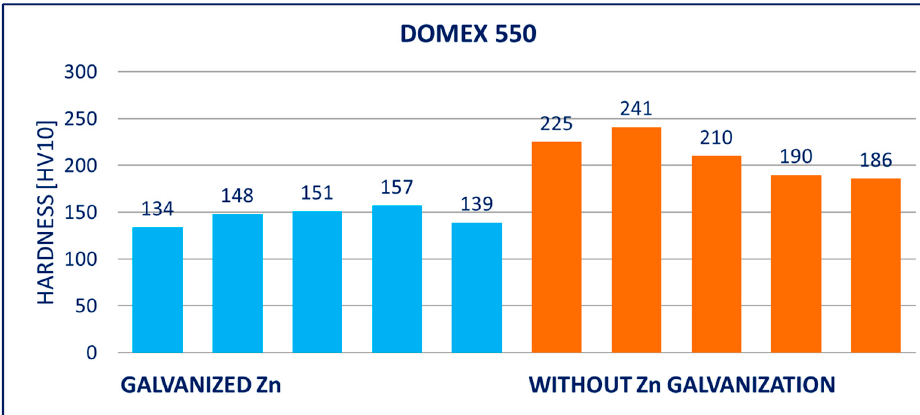
Figure 12. Results of hardness HV10 of specimens of DOMEX 450 steel.